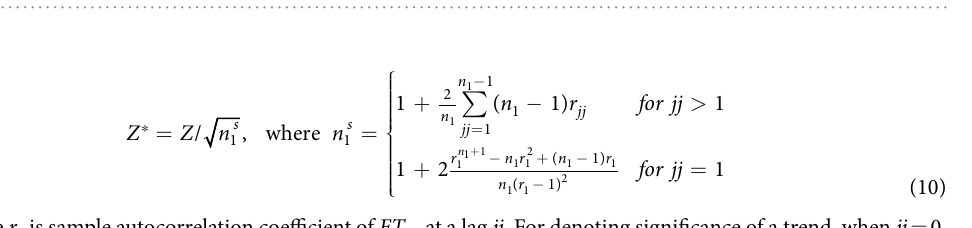
Figure 2. Spatial distributions of multi-year mean meteorological elements in China. (ArcGIS 10.2, http://map. baidu.com, Lingling